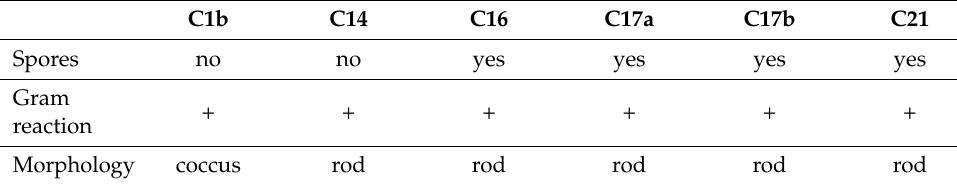
Table 4. Characteristics of the isolates with Mn-oxide-solubilizing